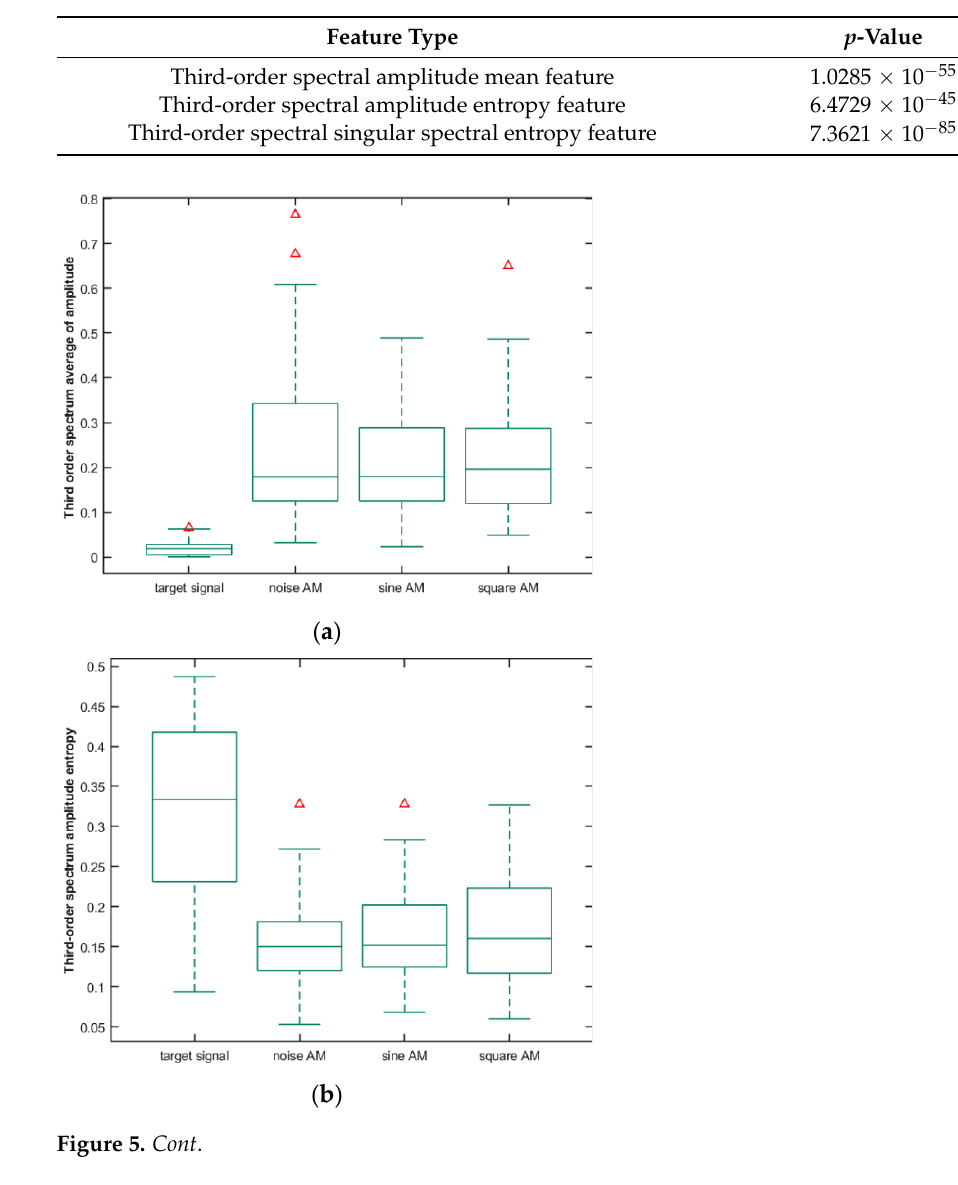
Table 1. Third-order spectral features significance test results.